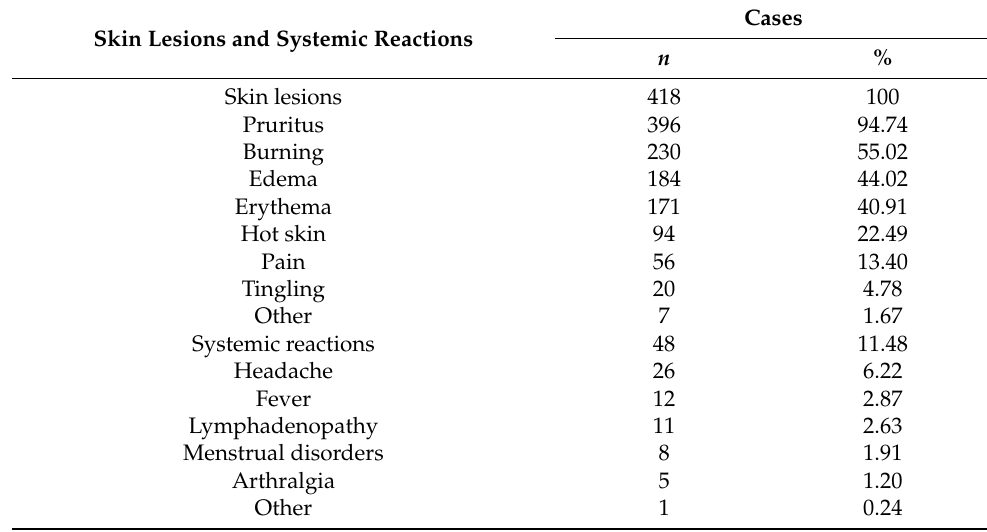
Table 1. Symptoms of skin lesions and systemic reactions induced by blackfly infestations in patients from southeastern Poland ( n = 418).